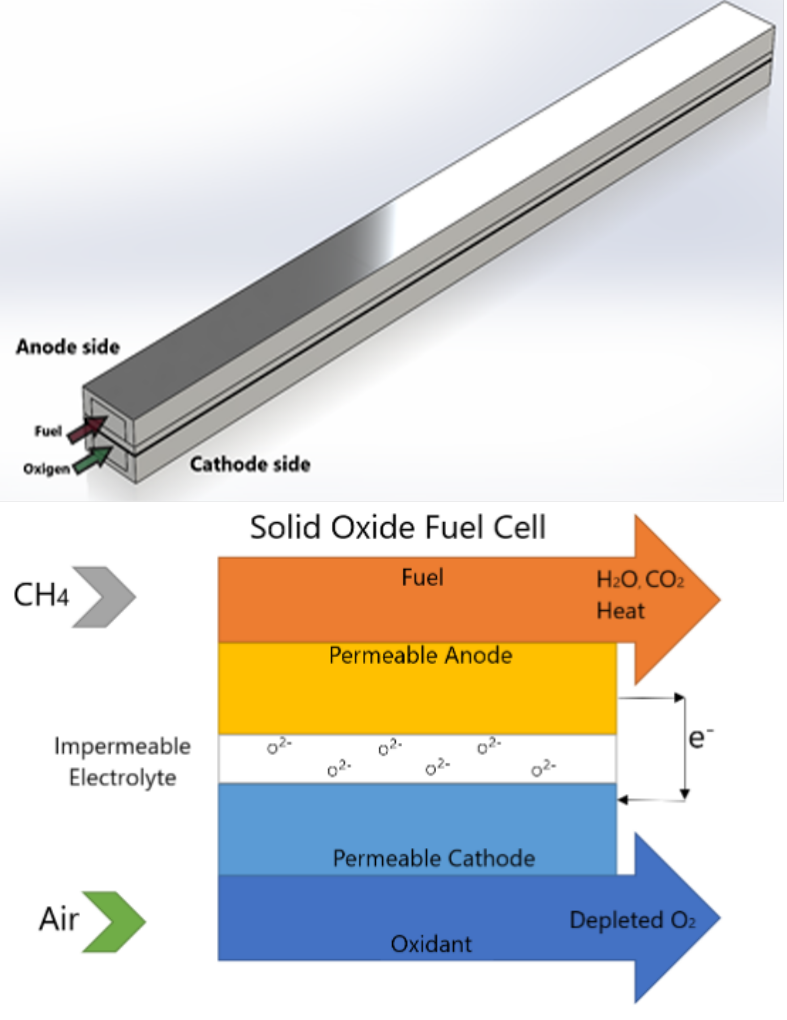
Figure 2. SOFC schematic and its